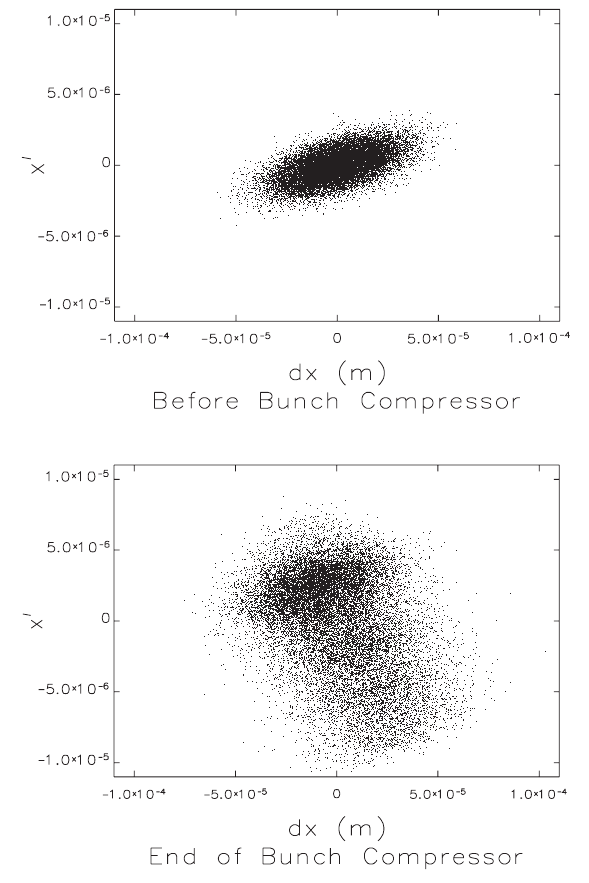
FIG. 5. Phase-space distribution before (top) and after (bot- tom) the bunch compressor. The longitudinal energy variation induced by CSR wakes is coupled to the coordinate and angular displacements through R 16 and R 26 induced in the chicane. This results in smearing of the transverse phase space.